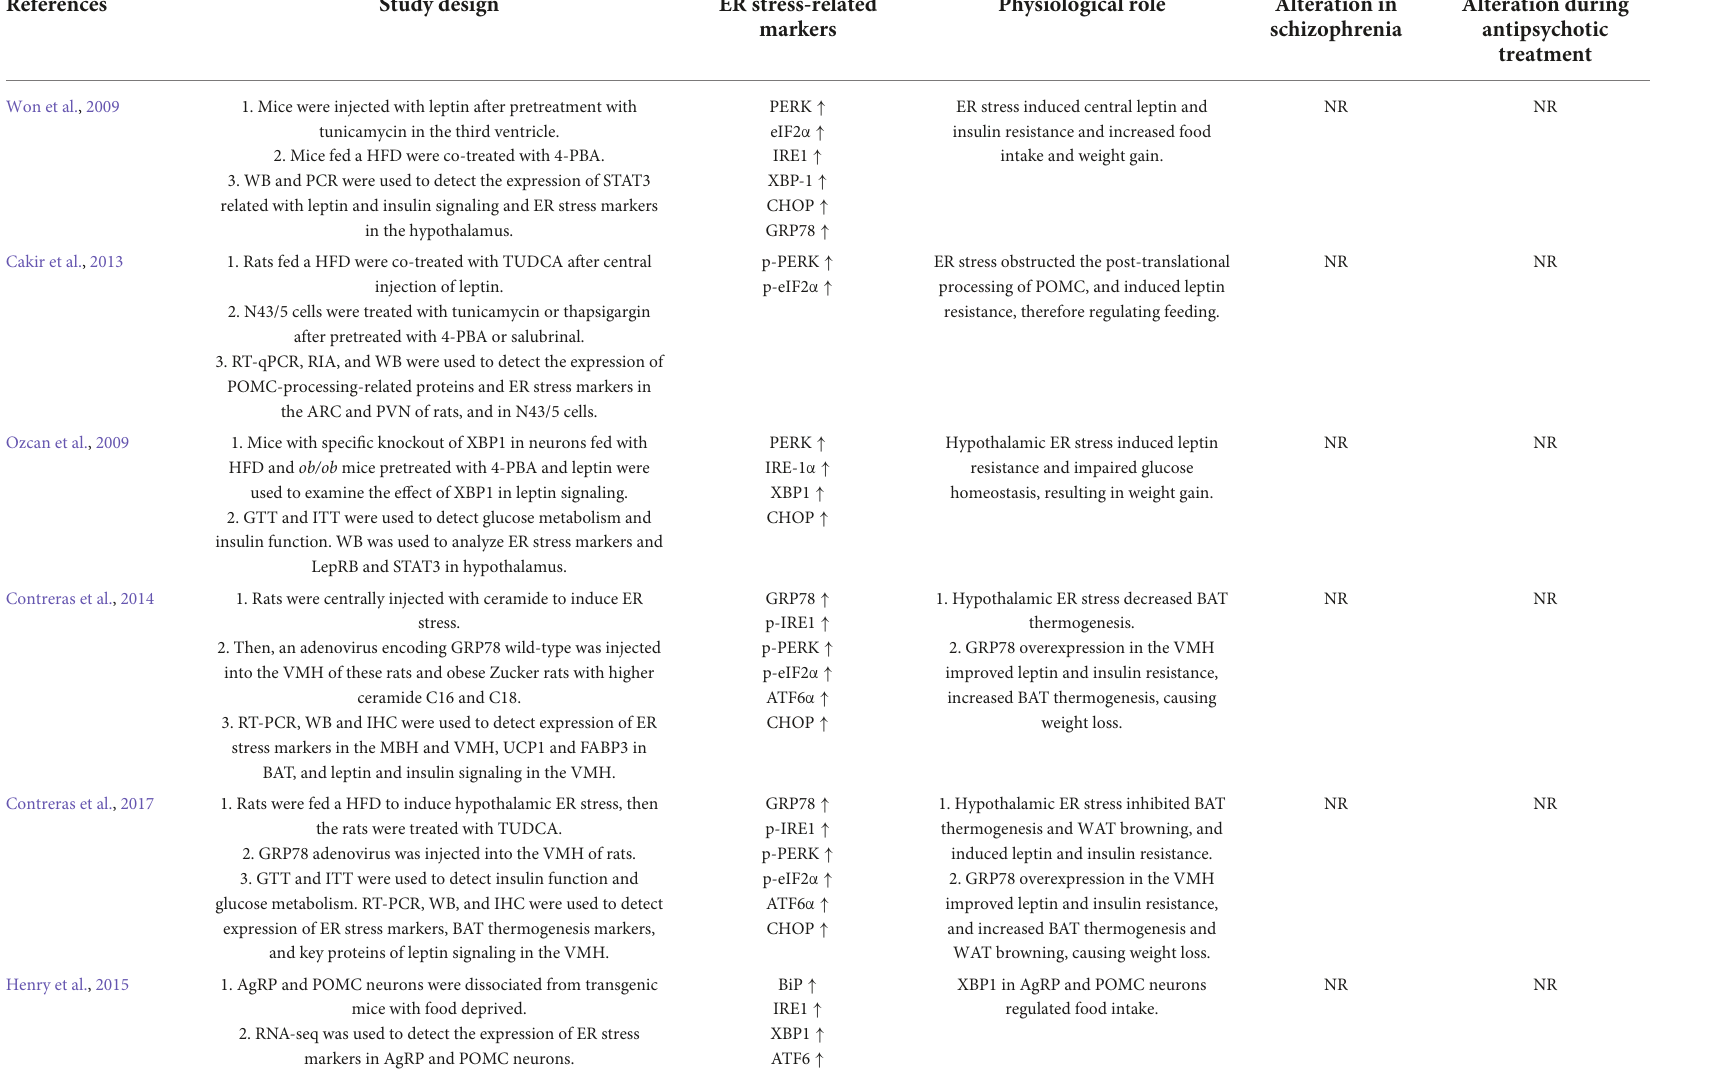
TABLE 1 Findings highlighting role of hypothalamic ER stress-related proteins in mediating appetite and weight gain and their modifications by antipsychotic